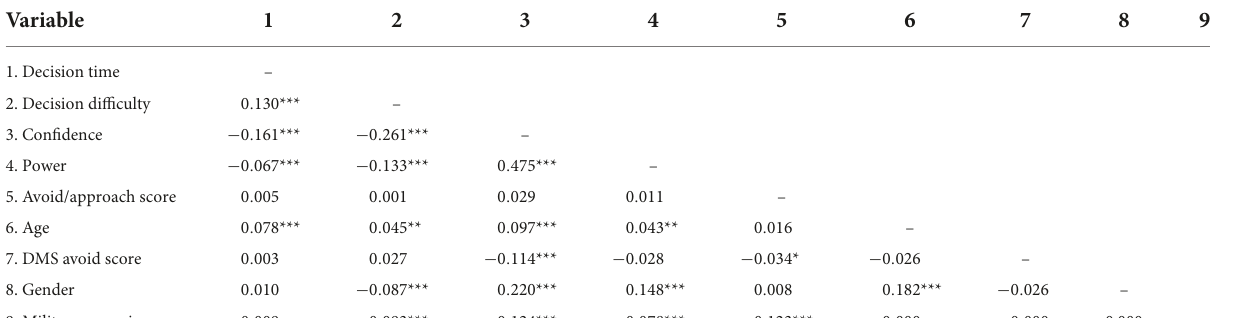
TABLE 6 Correlations between input